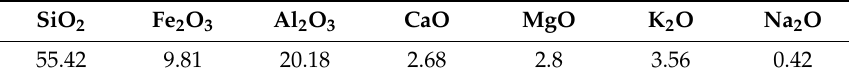
Table 3. Chemical Compositions of Coal Ash (wt%).